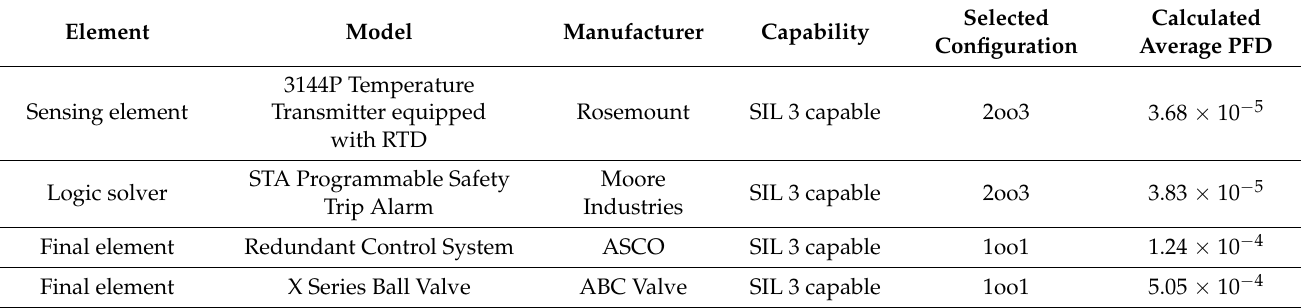
Table 7. Summary of the developed